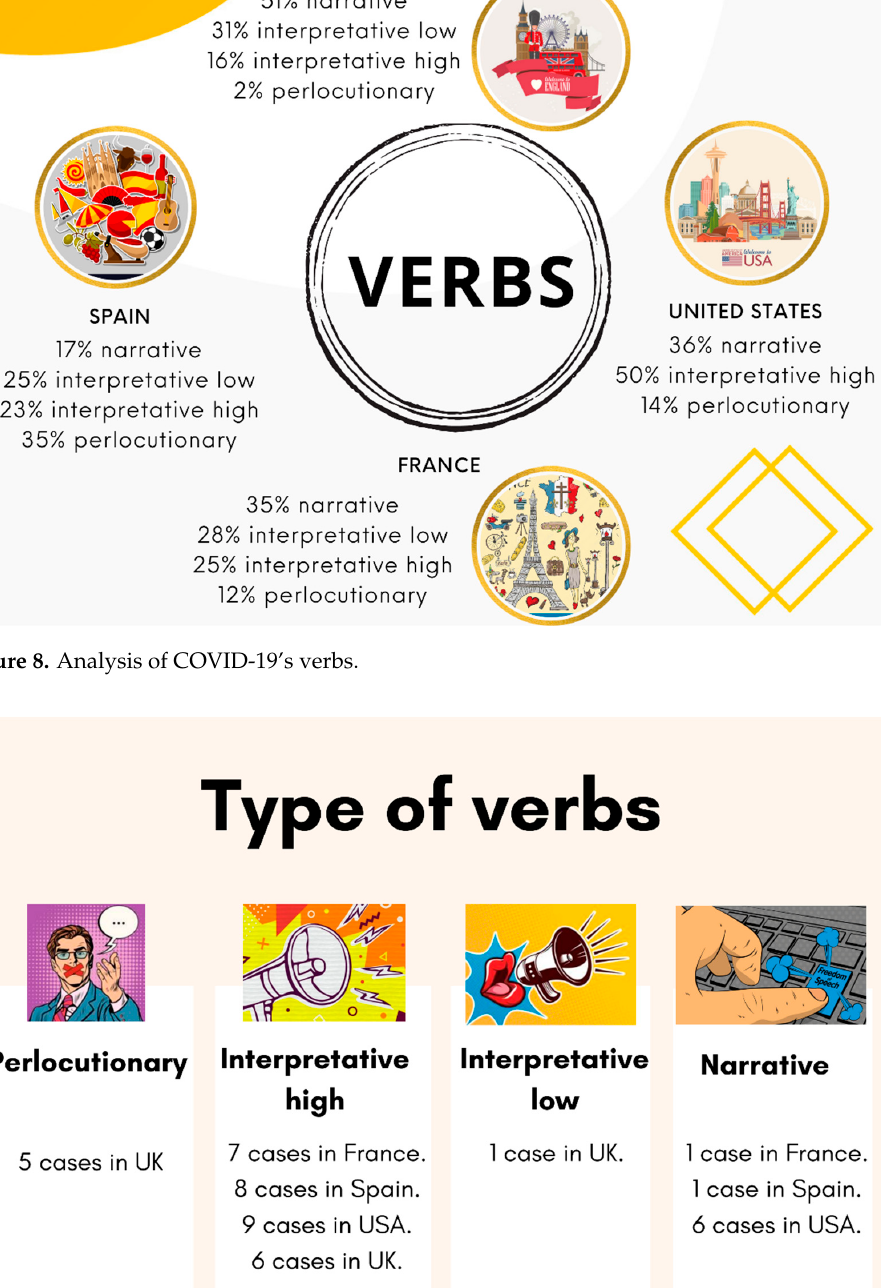
Figure 7. Analysis of vaccine headlines.